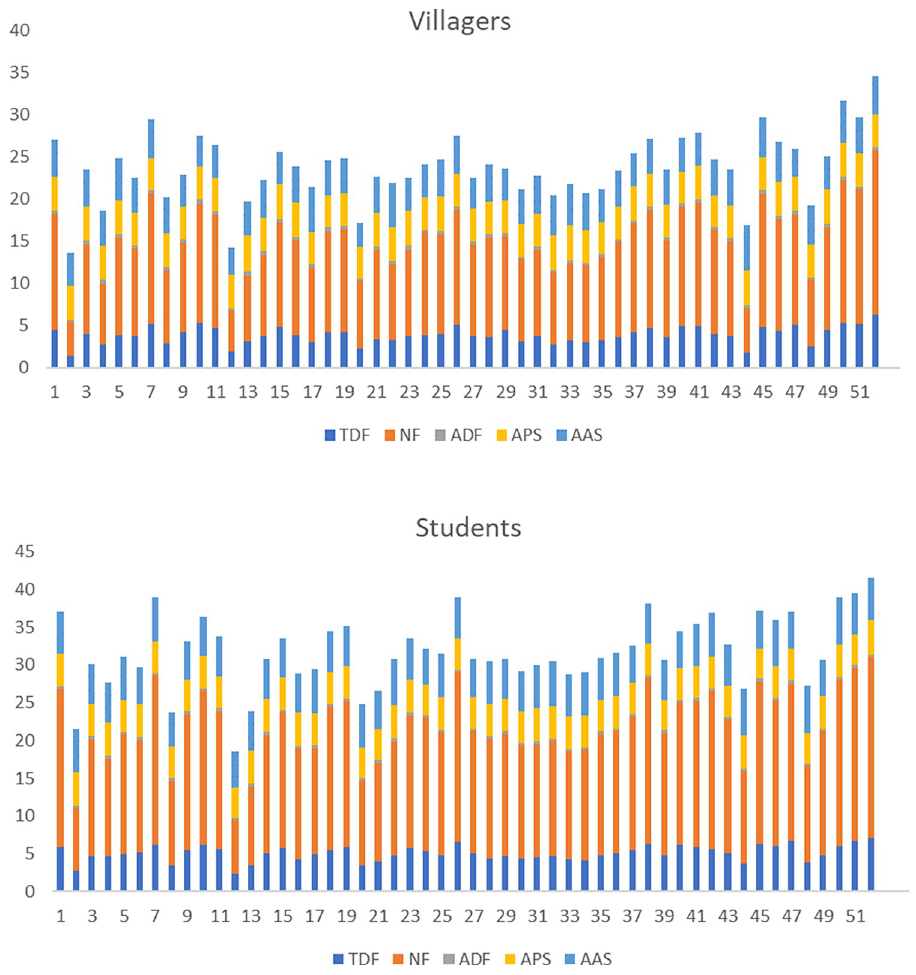
Fig 2. The mean value of eye movement indicators of villagers and students at species level. TDF: Total duration of fixations; NF: Number of fixations; ADF: Average duration of fixations; APS: Average pupil size; AAS: Average amplitude of saccades.1-52 respectively correspond to the species in Table